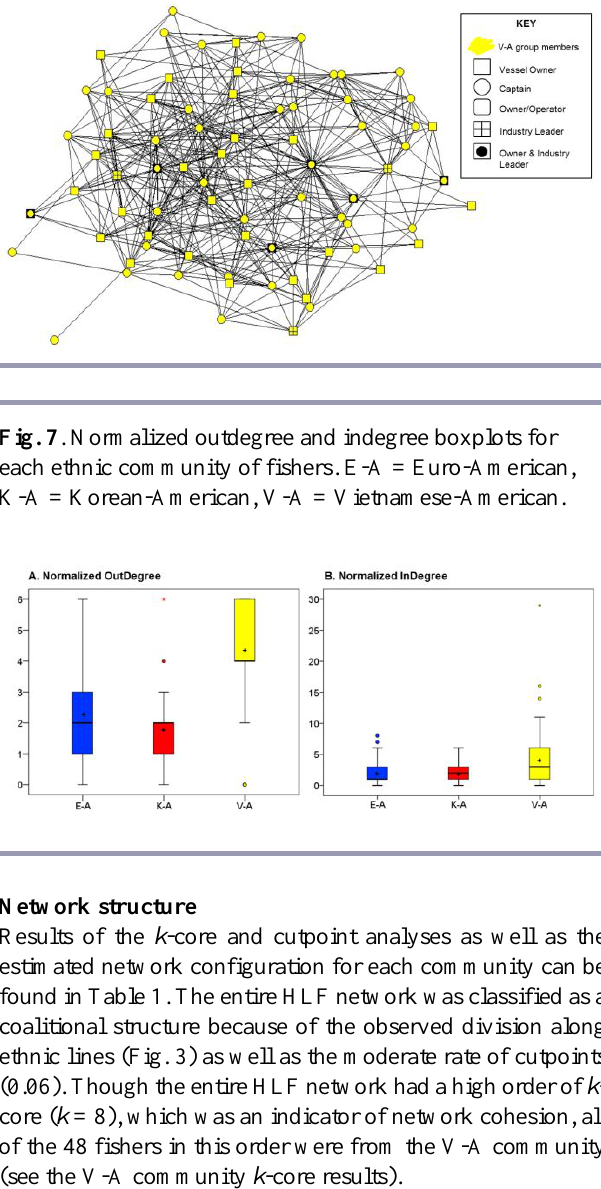
Fig. 6 . Network configuration of ties within the Vietnamese-American (V-A) community. Nodes (representing actors) with the smallest path lengths to each other are placed closest together by an algorithm that uses iterative fitting.